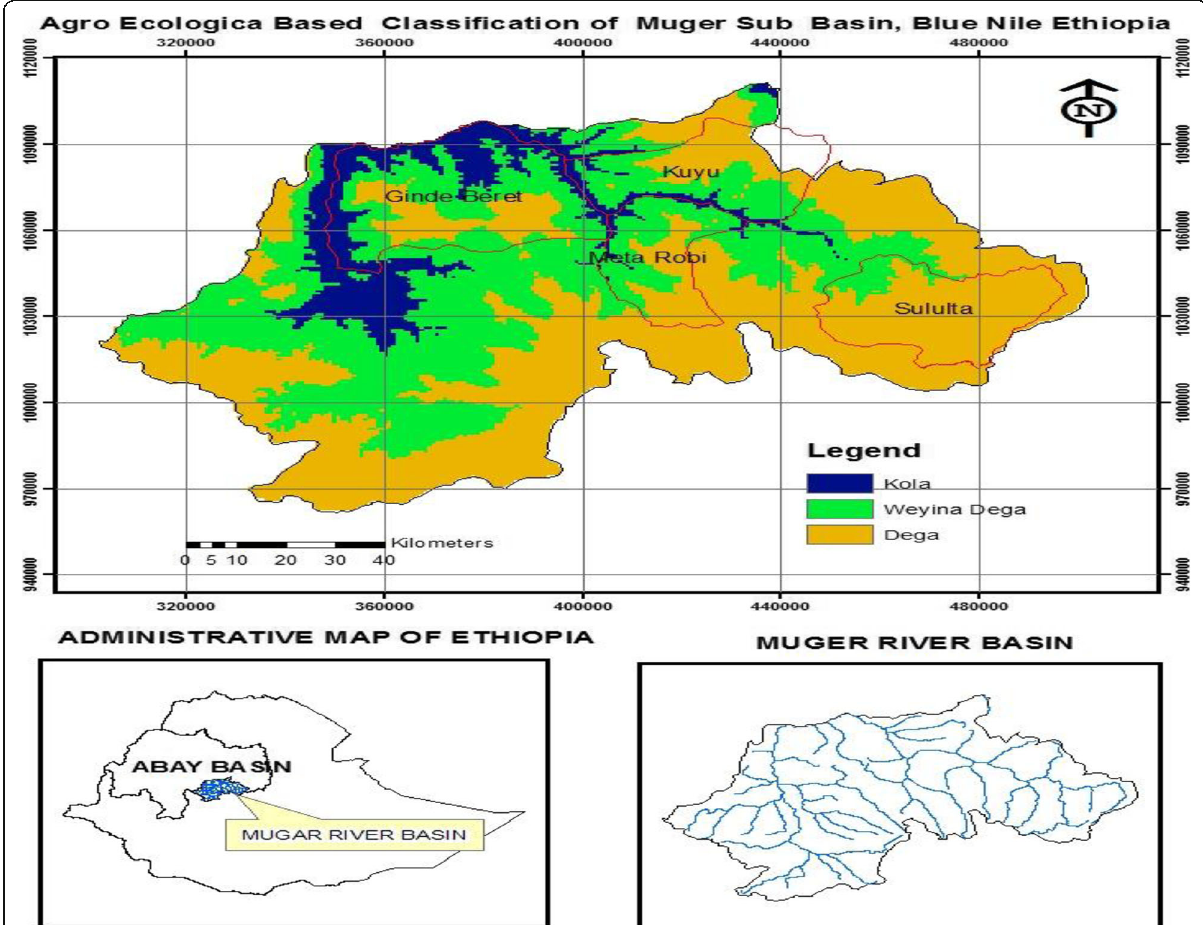
Fig. 1 Agroecology-based classification of Muger sub-basin of the Blue-Nile Basin of